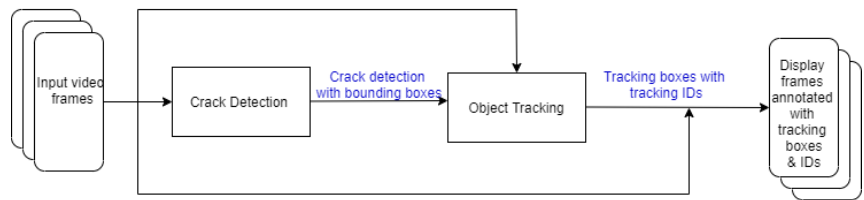
Figure 1. Detection-based crack tracking